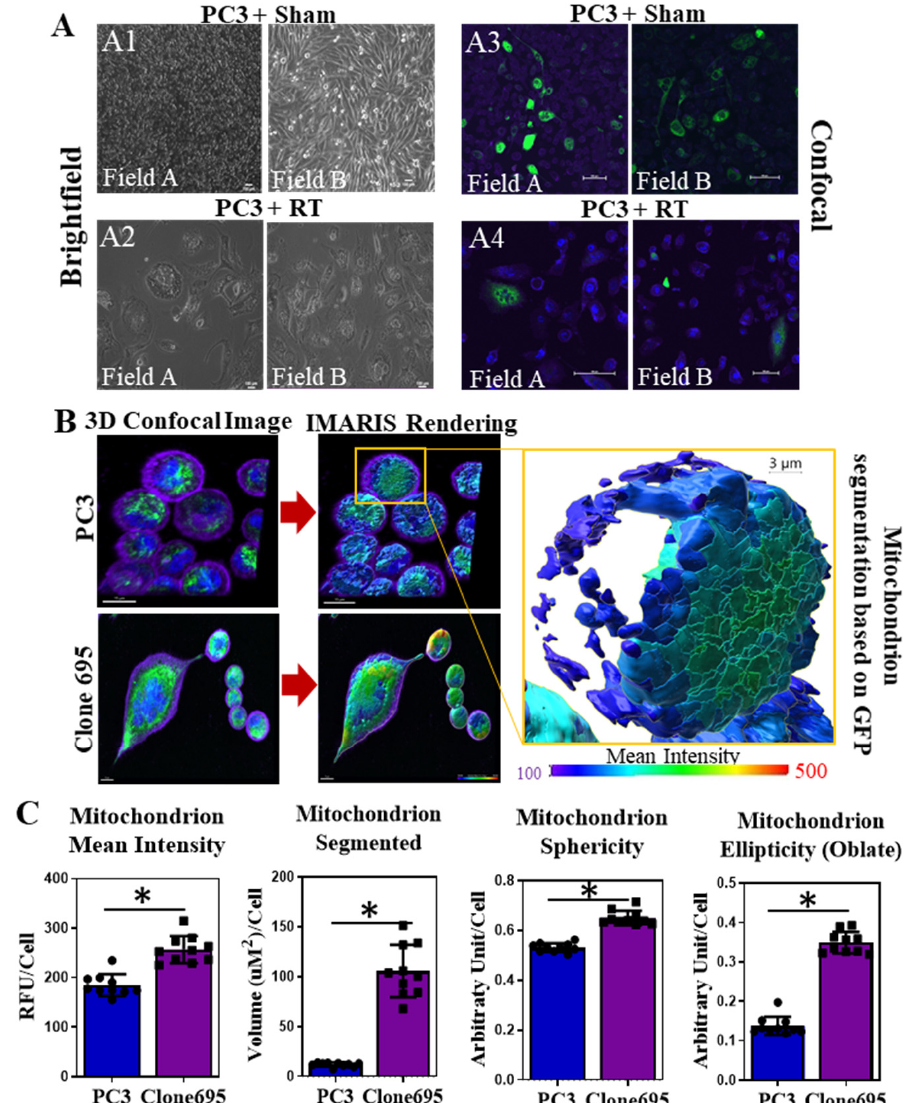
Figure 2. Clone 696 cells show distinct mitochondrial features compared to PC3 cells. ( A ) Cell morphology observed during PC3 cells treated with fractioned RT (clone 695 development). Cells that were exposed to RT altered their morphology with abundance mitochondria observed in cells with larger size. ( A1 ) Brightfield images from two different fields and ( A3 ) confocal images from two different fields, of PC3 cells taken at 0 Gy RT (sham). ( A2 ) Brightfield images from two different fields and ( A4 ) confocal images from two different fields, of PC3 cells after treated with 38 Gy RT. Scale bar = 100 µ m. Green = Mitochondria, Blue = Nucleus, Purple = membrane. ( B ) Confocal images of PC3 cells and Clone 695 cells converted into IMARIS file for visualization of segmented mitochondria in a single cell. Scale bar = 100 µ m. ( C ) Quantitative analysis of each mitochondrion segmented per cell for mitotracker green intensity, mitochondrial volume, mitochondrial sphericity and mitochondrial ellipticity, compared between PC3 cells and clone 695 cells. Circles and squares represent individual data points within PC3 and Clone 695 samples. * p -value < 0.01.